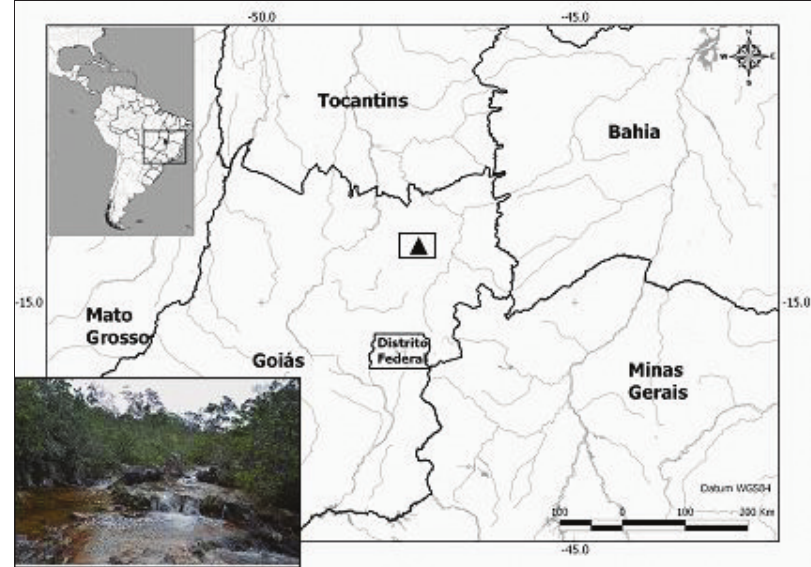
Figure 1. Study area. Type locality indicated with triangle. Insert shows the type locality (Água Fria River, National Park of the Chapada dos Veadeiros, Brazil) of Eirinicaris antonioi sp.